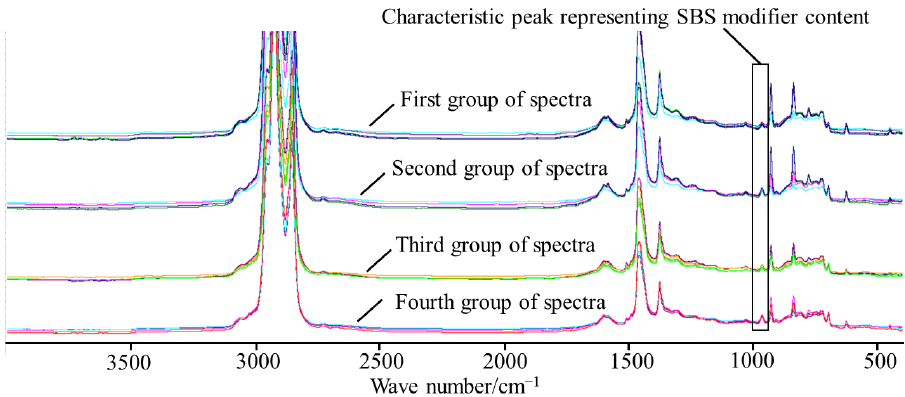
Figure 1. Infrared spectra of modified asphalt with different types of SBS modifiers.